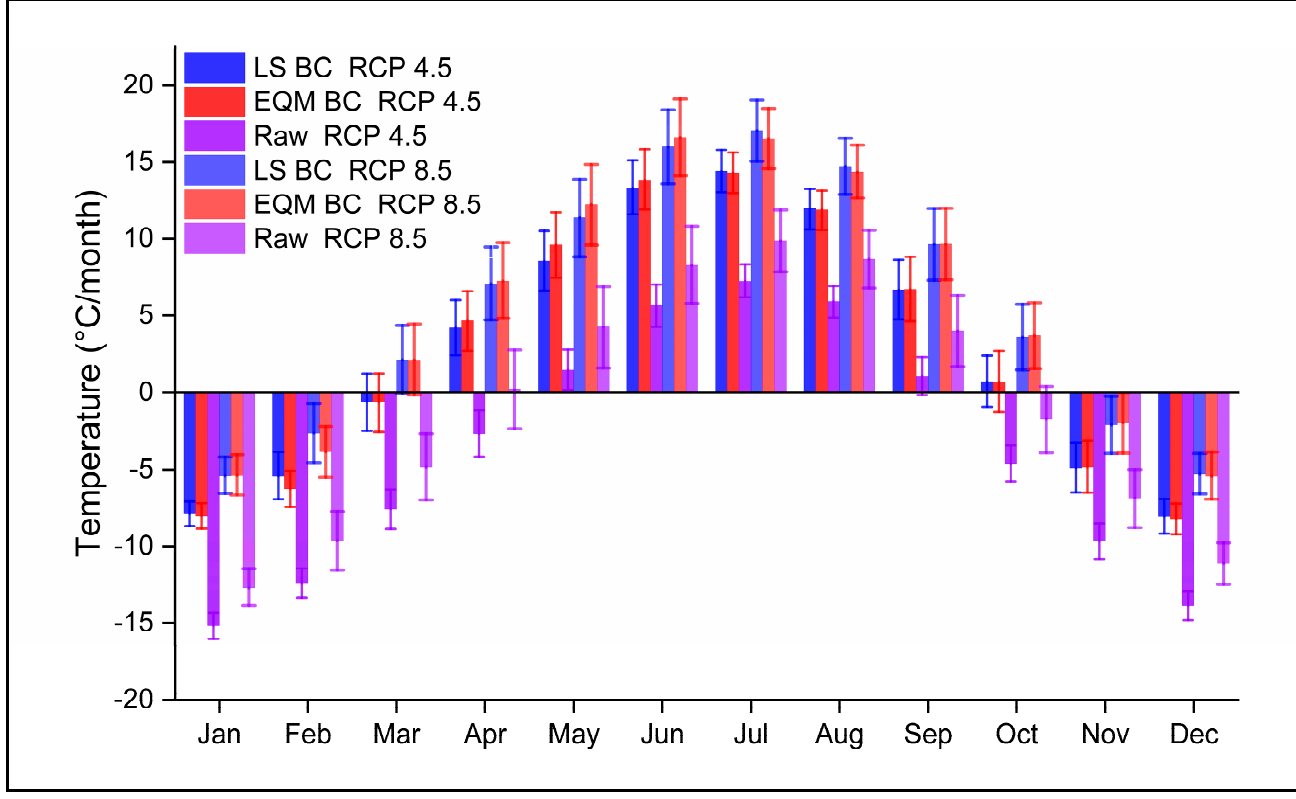
Figure 11. As Figure 6, but for the period 2070–2099.